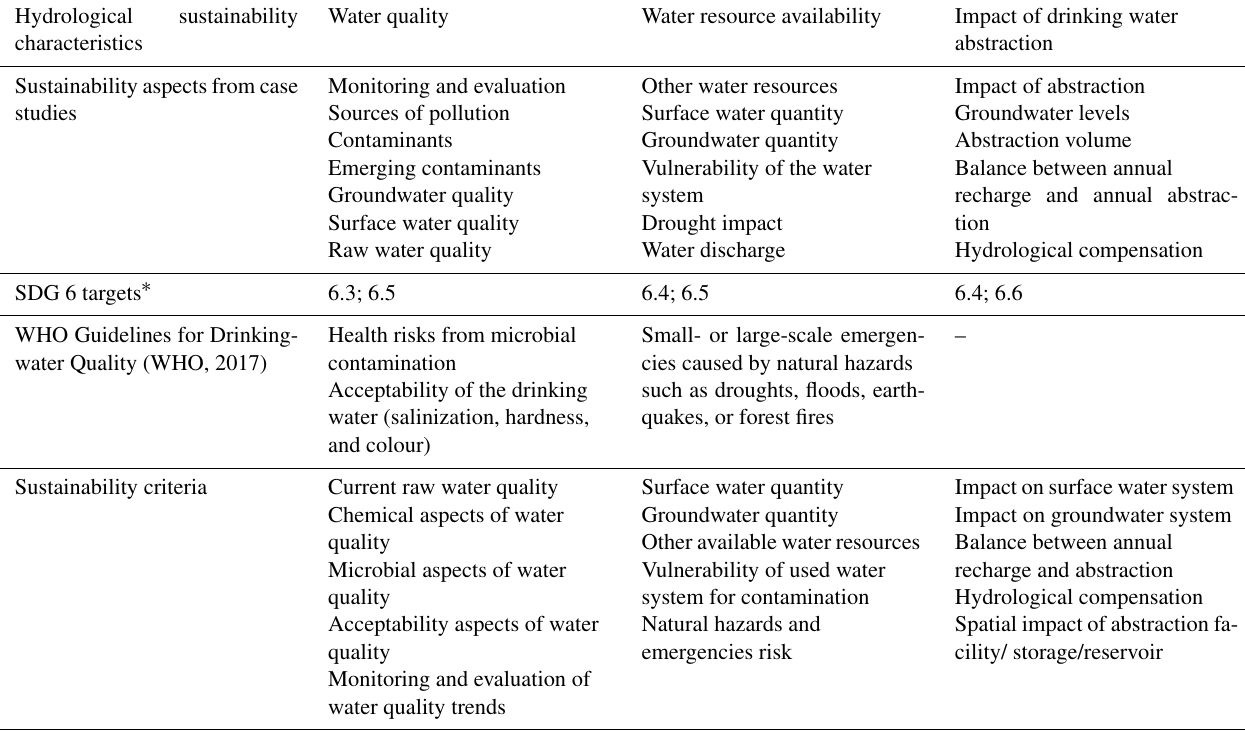
Table 1. Summary of proposed hydrological sustainability characteristics, hydrological aspects from case studies (see Appendices A–C), relevant SDG ∗ indicators and WHO Guidelines for Drinking-water Quality (WHO, 2017) aspects, and hydrological sustainability